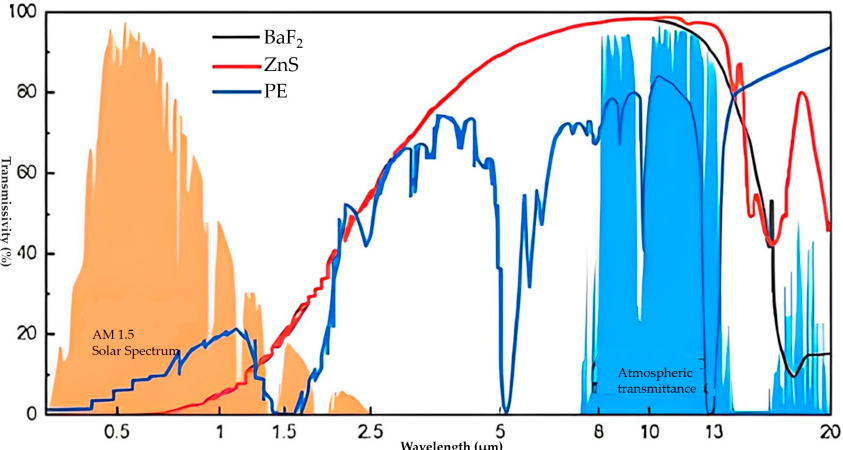
Figure 37. The transmission spectra of BaF 2 , ZnS, and PE coatings, as well as a typical atmospheric transmittance, are depicted in orange and blue, respectively [42,173].